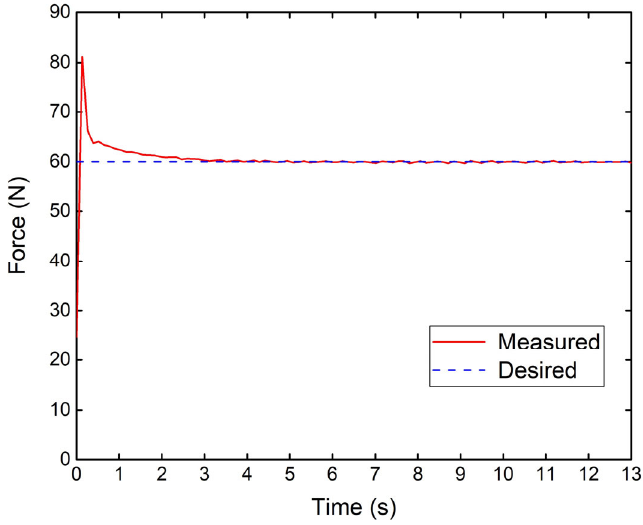
Figure 13. Step response curve of feedforward control and PID control.